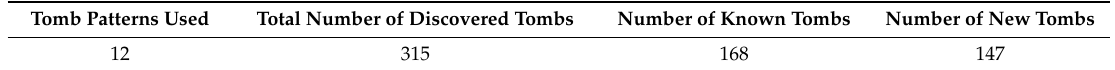
Table 1. Statistical results of the discovered Chu tombs.